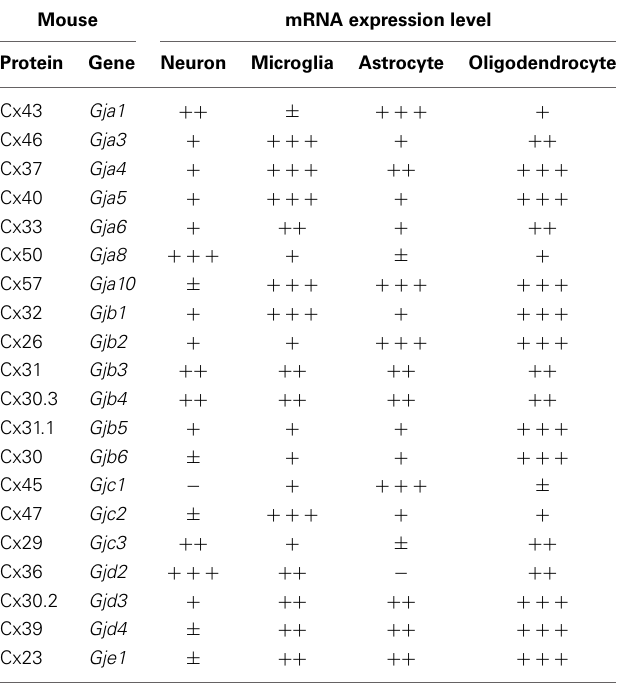
Table 1 | mRNA expression levels of mouse connexin in CNS